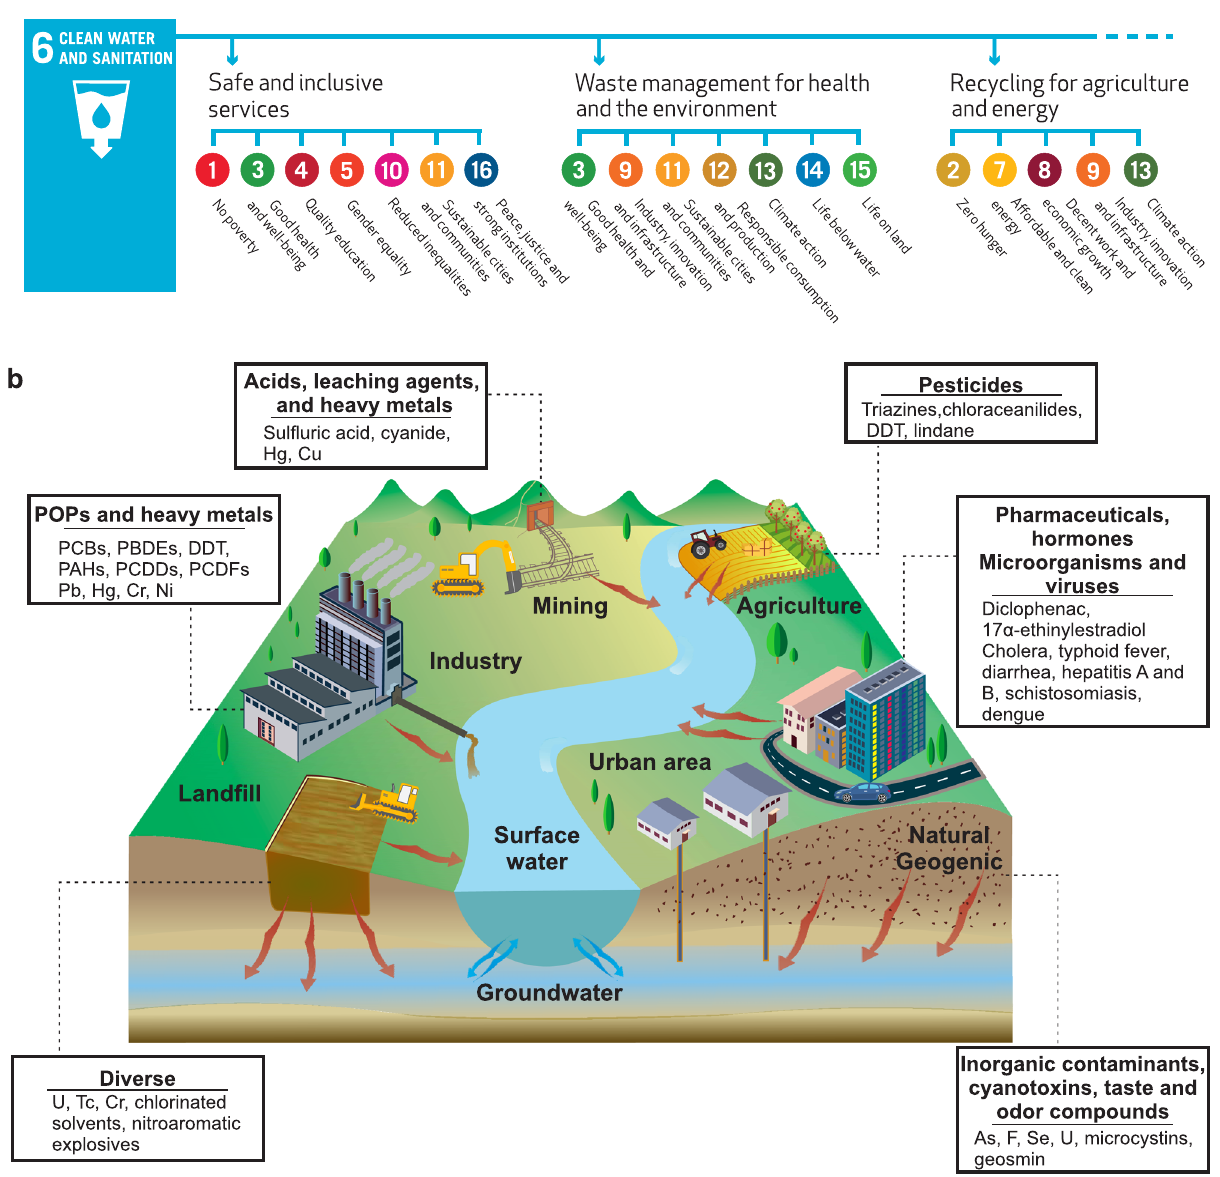
Fig. 1 Importance of water and its main sources of pollution. a The role of clean water and sanitation (SDG 6) in achieving the other SDGs 2 . b Major contaminants of the world water bodies and their sources of release 106 . Panel a reproduced with permission from ref. 2 , Stockholm Environment